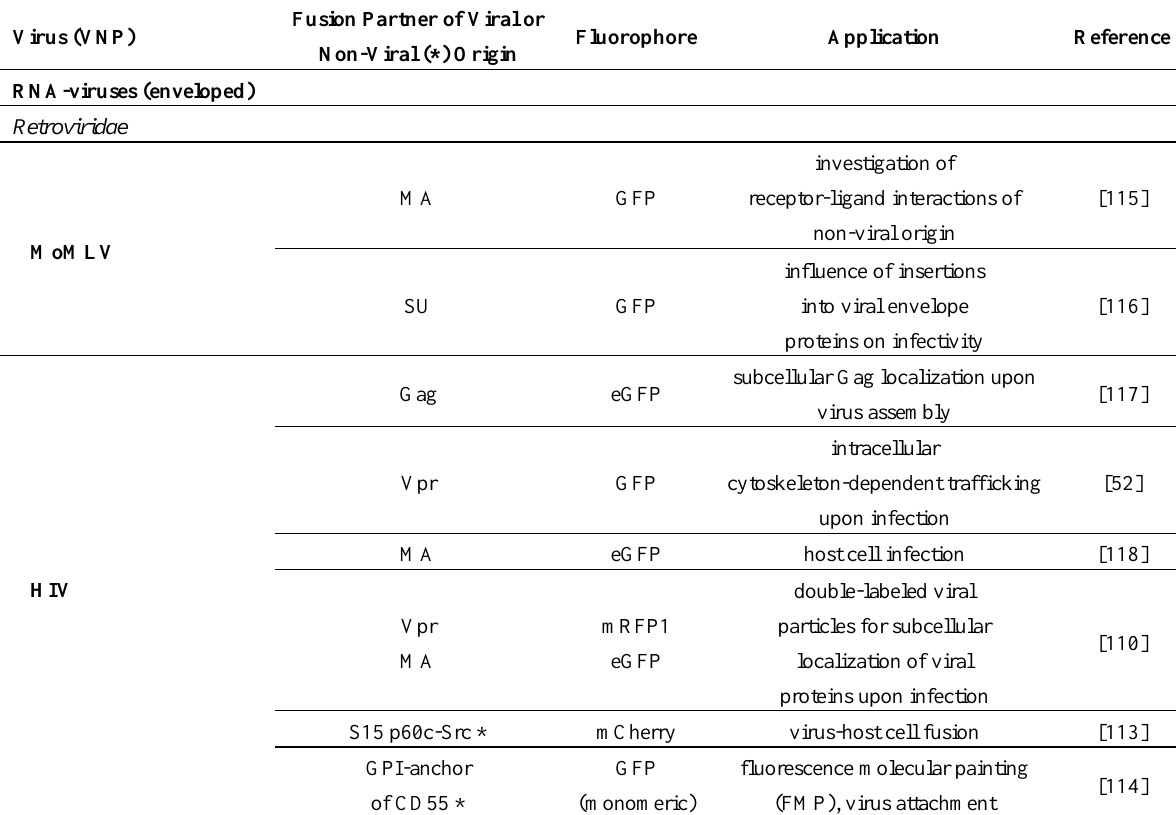
Table 2. Generation of fluorescent viral particles by genetic fusion of fluorophores to proteins of viral and non-viral